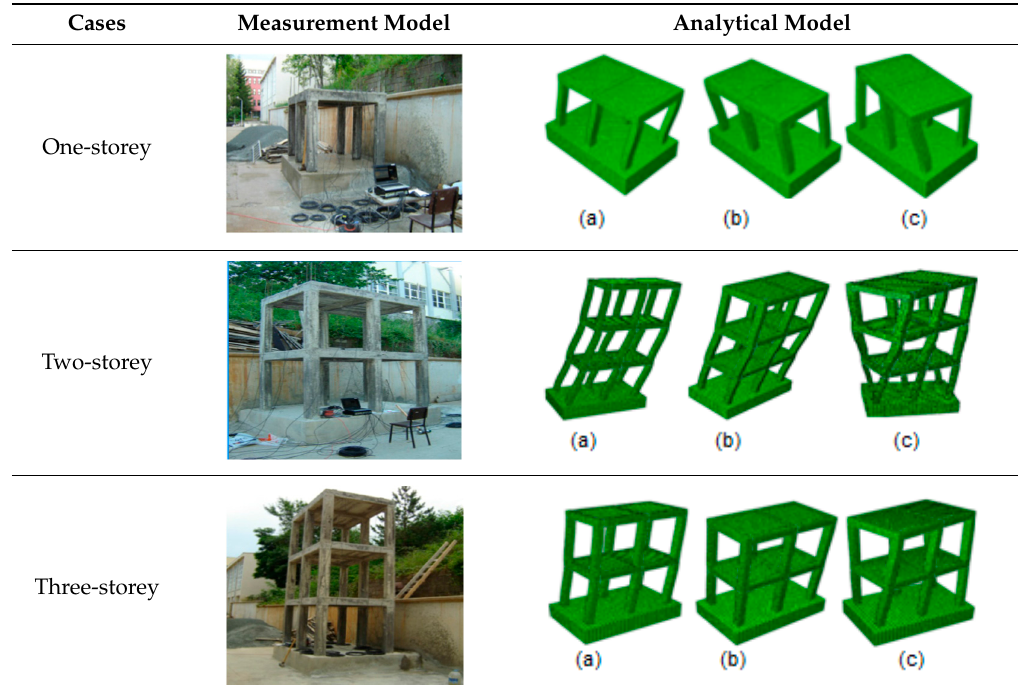
Figure 4. Comparison between natural frequencies for construction stages.